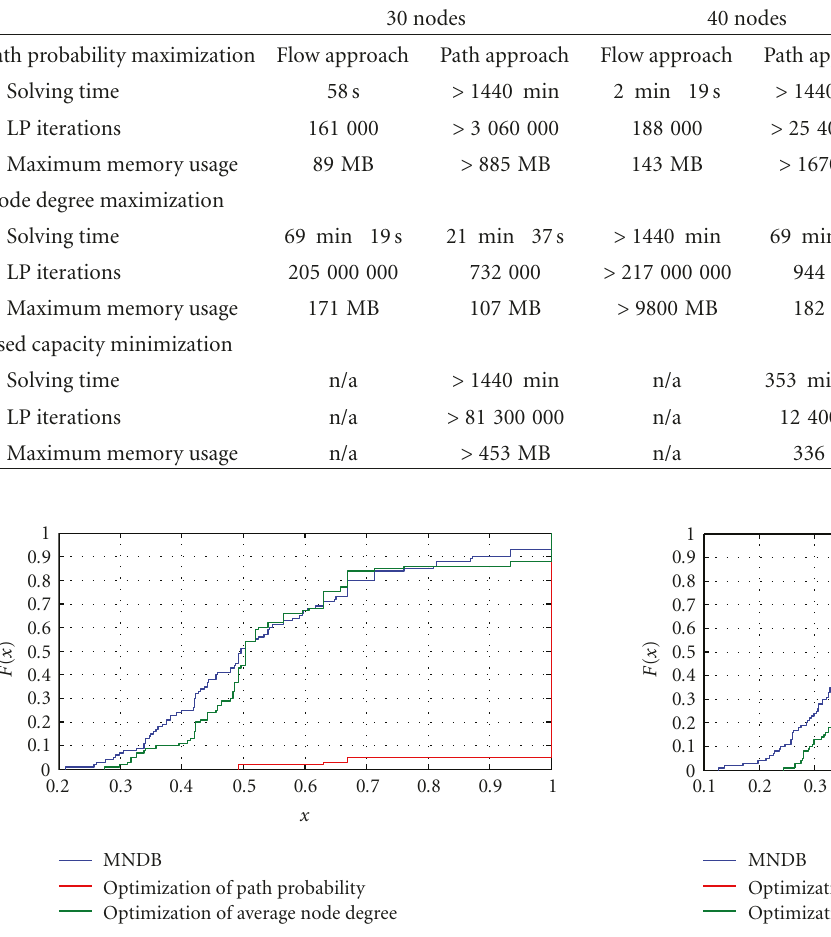
Figure 10: CDF of path probability, comparison of MNDB, optimization of path probability, and optimization of average node degree, P t = 20dBm.